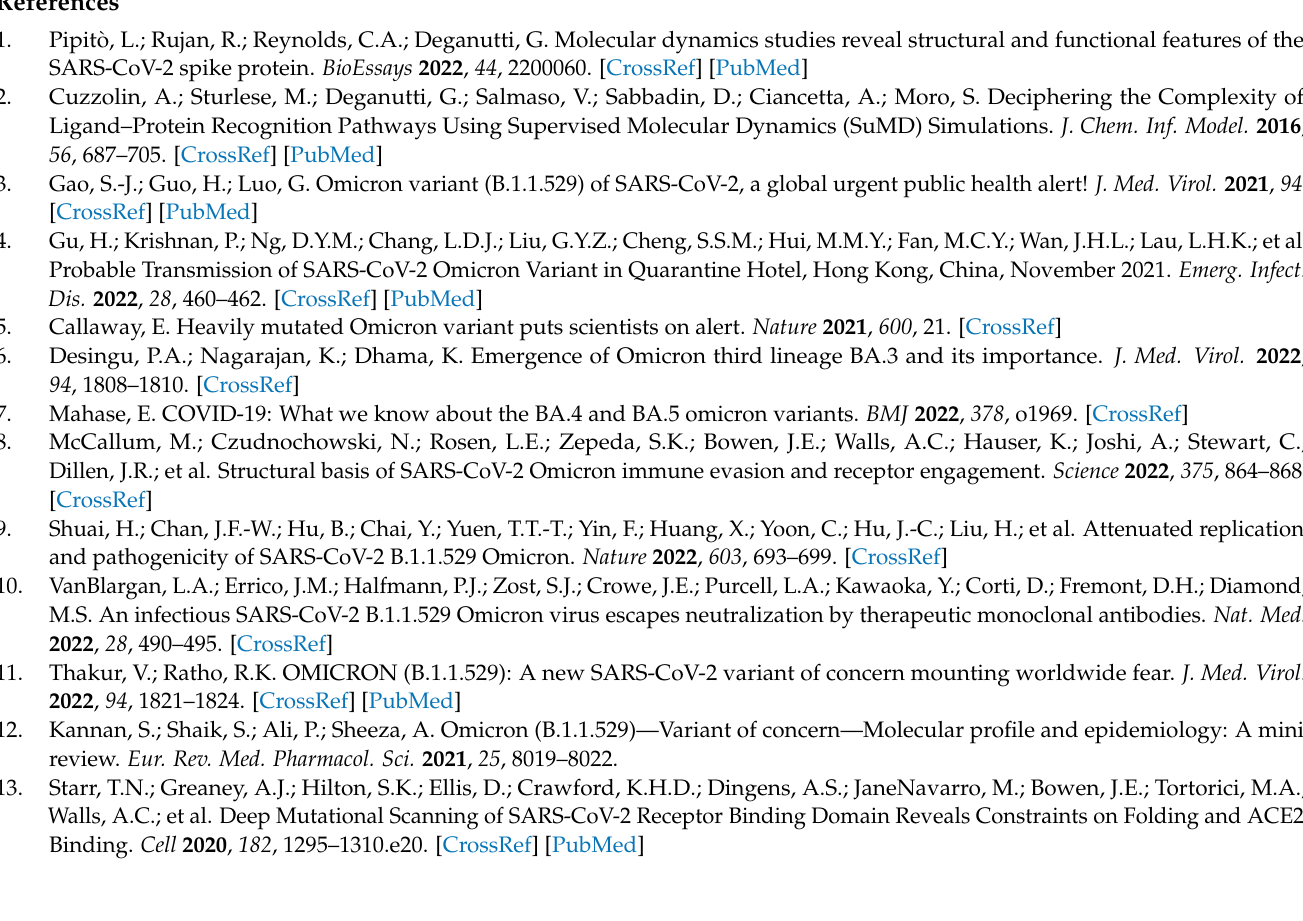
binding to ACE2; red residues interacted more in RBD ◦ while blue residues were more engaged in RBD ∆ . (b) Comparison between the hydrogen bonds formed by RBD ∆ or RBD ◦ in the unstable states of SuMD binding to ACE2; red residues interacted more in RBD ◦ while blue residues were more engaged in RBD ∆ . (c) RBD BA.2 contacts in the unstable states of SuMD binding to ACE2; red residues interacted with ACE2, while cyan residues were not engaged. Table S1. Omicron mutations and deletions. Residues within the RBD are in bold. Table S2. Summary of the MD simulations performed. Table S3. MM-GBSA Energy from MD simulations of ACE2 in complex with RBD WT , RBD ∆ , and RBD ◦ . Table S4. Hydrogen Bonds between ACE2 and RBD ∆ or RBD ◦ during SuMD binding or classic MD simulations. Residues that differ between RBD ∆ and RBD ◦ are in bold. Table S5. Per S1 residue energy contribution to SuMD binding USs. Table S6. Per ACE-2 residue energy contribution to SuMD binding